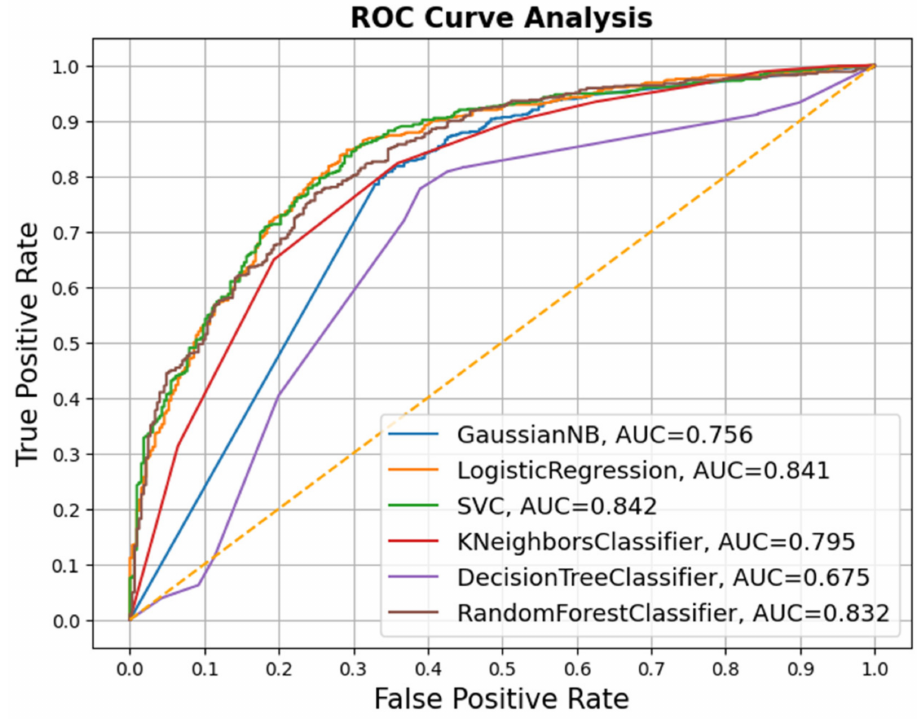
Figure 2. ROC curves of ML classifiers on COVID-19 Fake News